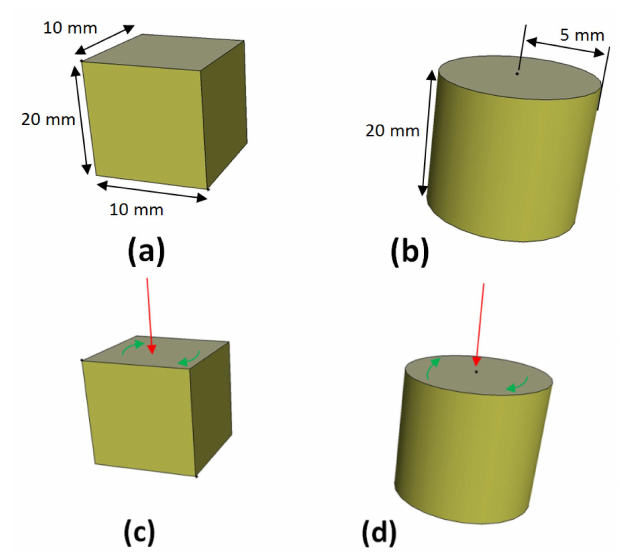
Figure 29. Segmentation will be done intensively, magnet size will be low. A specimen ( a ) having a representative size is submitted to a variable magnetic field ( c ); a magnet having similar volume, but which can be modeled as an axisymmetric model ( b ) is submitted to the same magnetic field ( d ). Eddy current losses are compared for these both cases.